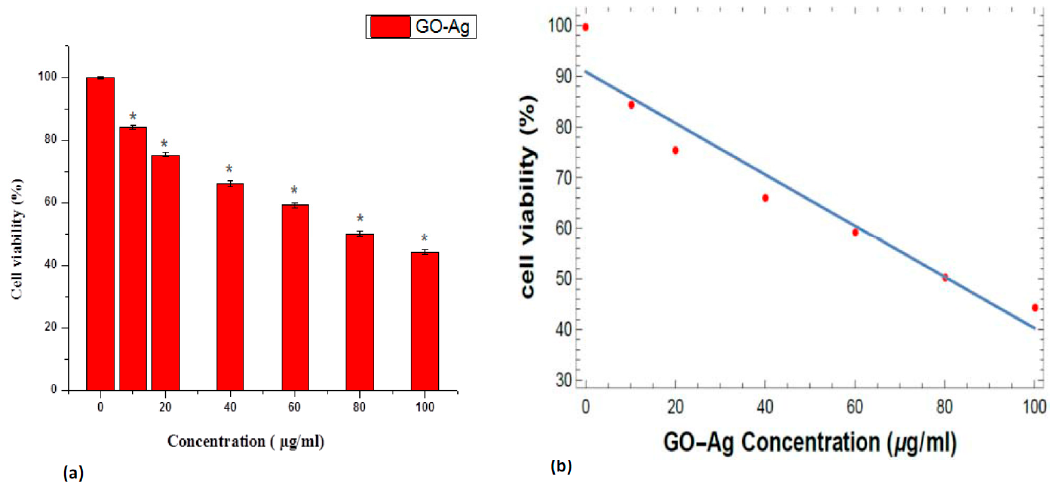
Figure 6. ( a ) Loss in cellular viability (%) in MCF-7 breast cell line treated with GO-Ag nanocomposites after 24 h, t -test ( * p < 0.05) ( b ) Linear calibration Plot of GO-Ag vs. cell viability.